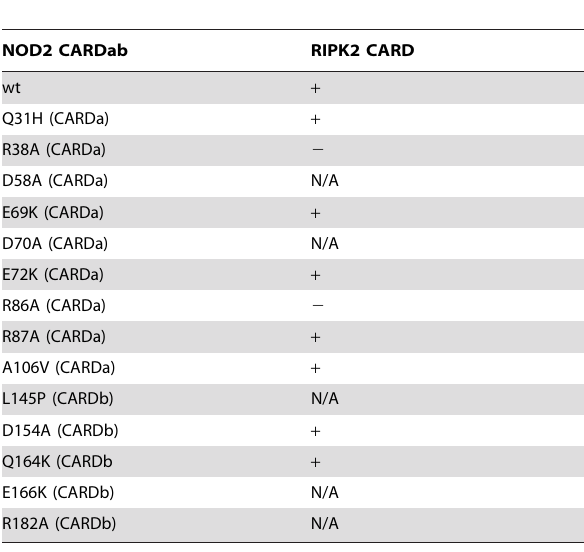
Table 4. The interaction of RIP2 CARD mutants with NOD2 CARDab and NOD1